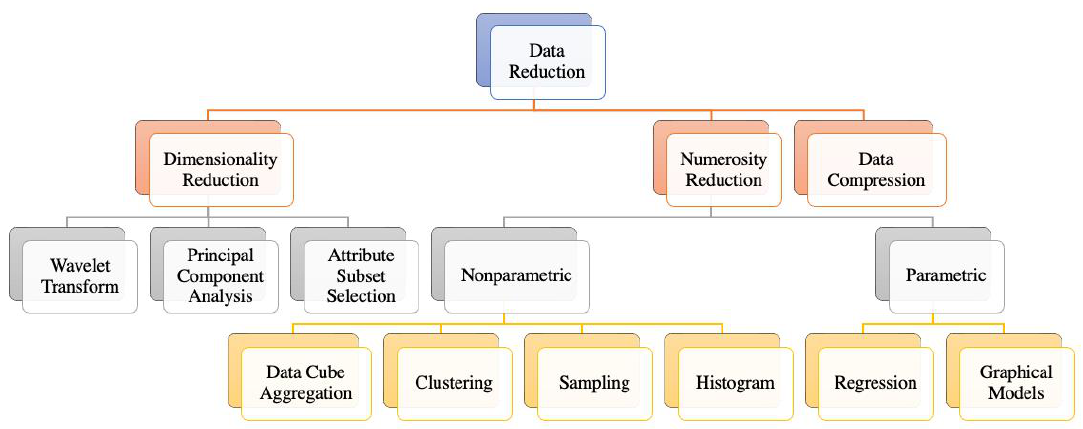
Figure 4. Taxonomy of common classes of data reduction